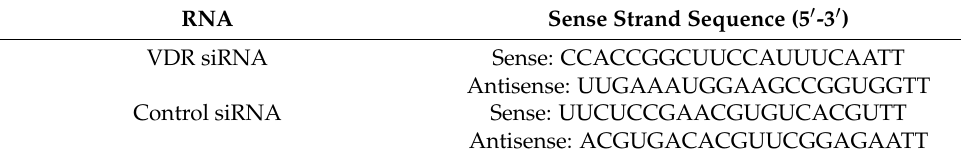
Table 2. Sequences of VDR siRNA and control siRNA. RNA Sense Strand Sequence (5 (cid:48) -3 (cid:48)